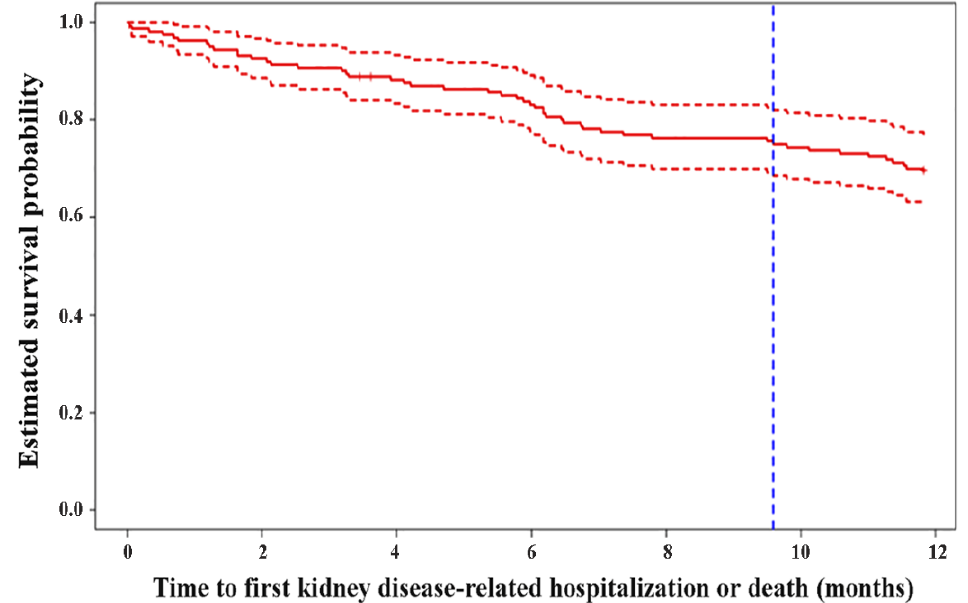
Figure 2. Kaplan−Meier estimate of survival curve of time to the first kidney disease-related hospi- talization or death. The 75th percentile of survival time was approximately 9.5 months. Table 2. Multivariate analysis of the predictors of time to the first kidney disease-related hospitali- zation or death using a Cox proportional hazards model in ESRD patients on regular hemodialysis.